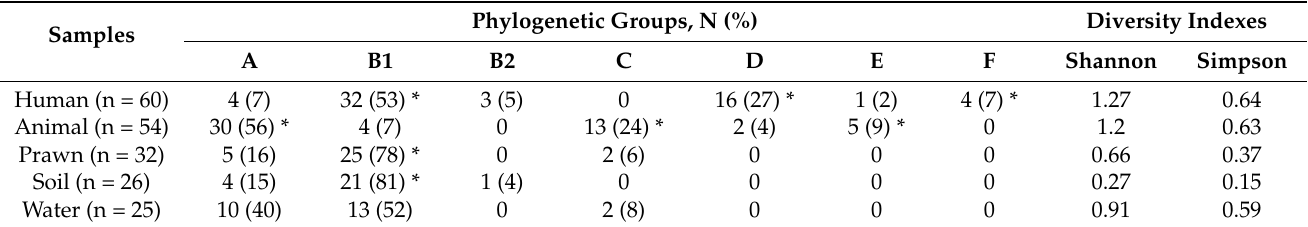
Table 5. Distribution of phylogenetic groups among E. coli isolated from different samples. Phylogenetic Groups, N (%) Diversity Indexes Samples F Shannon